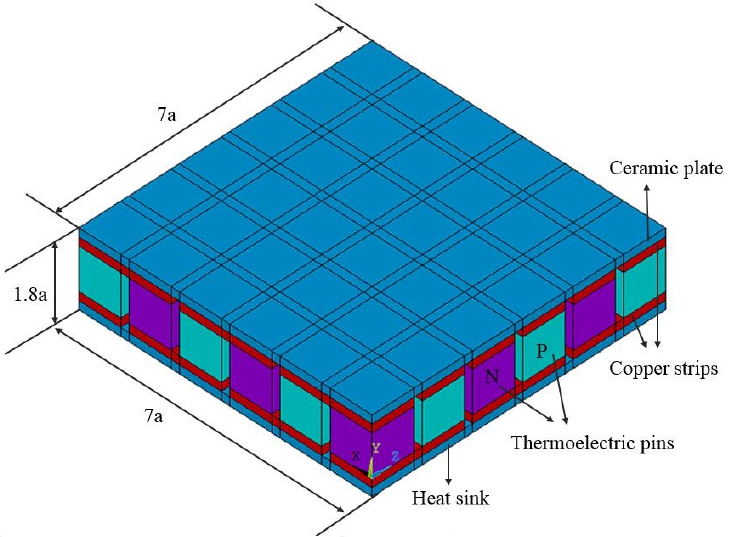
Figure 1. Geometric dimensions of the thermoelectric model.